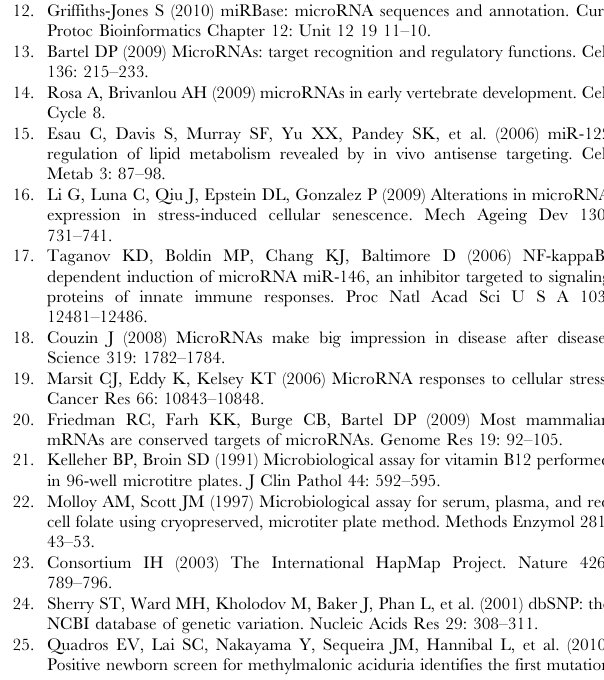
not present within a predicted microRNA target